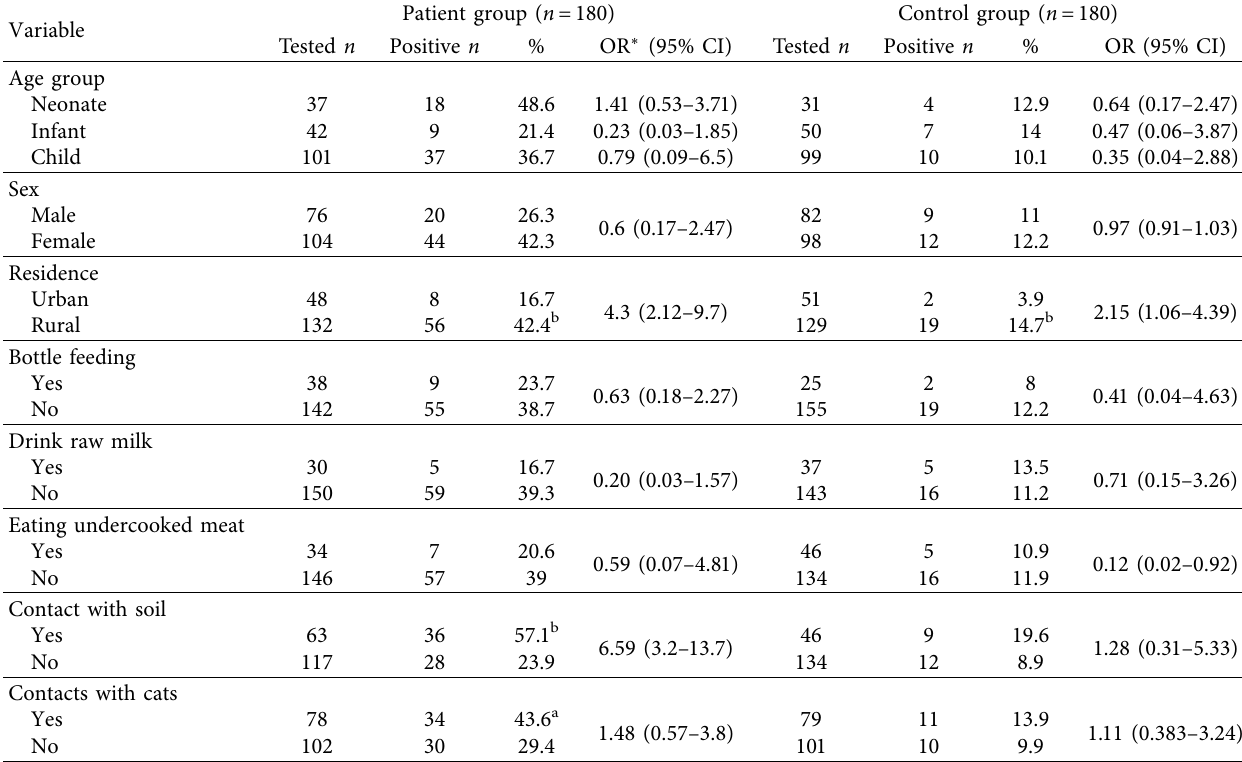
Table 2: Seropositivity of T. gondii infection in relation to risk factors among the patient (children with neurodevelopmental disorders) and control groups.